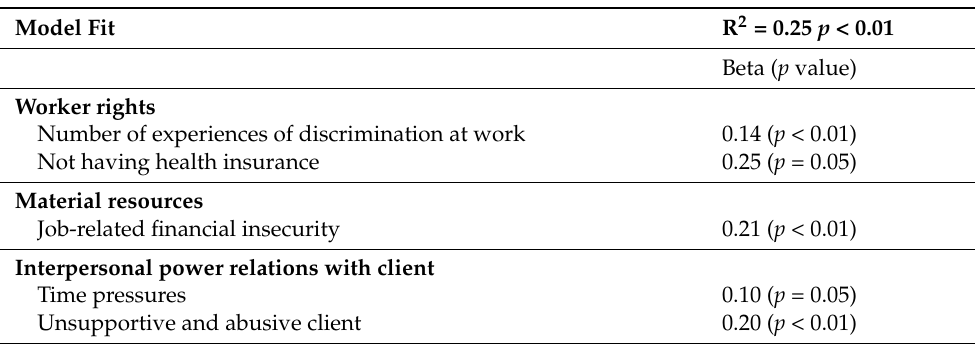
Table 5. Multiple linear regression model for associations between employment quality dimensions and work-related irritant symptom